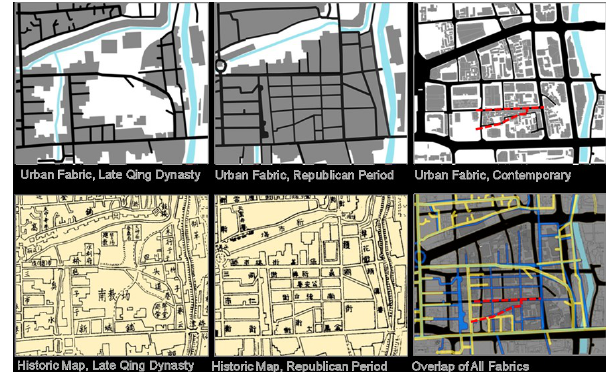
Figure 4. Historic Maps and Urban Fabrics of Nanqiang Street 4.1.2